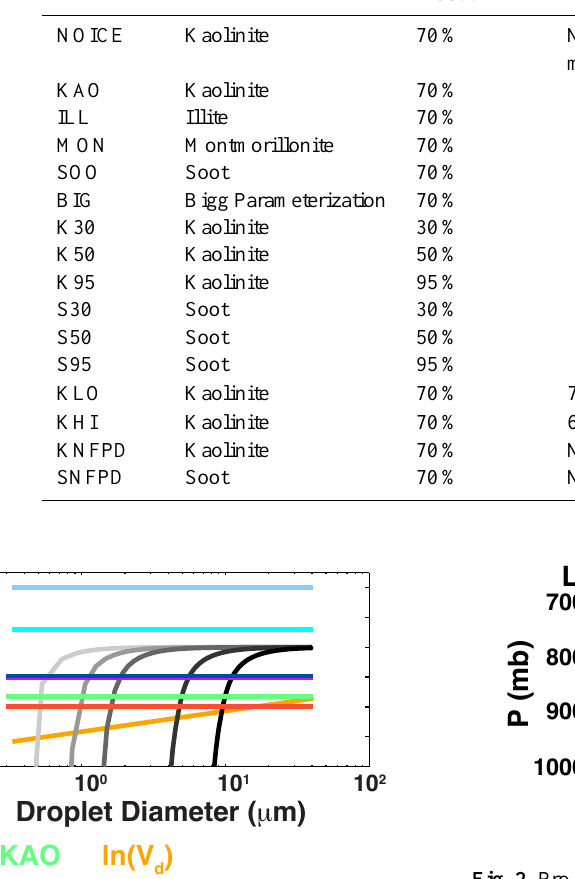
Fig. 2. Profiles of cloud liquid water (a) , relative humidity (b) and potential temperature (c) used for the 7–8 May simulations (from Morrison and Zuidema,